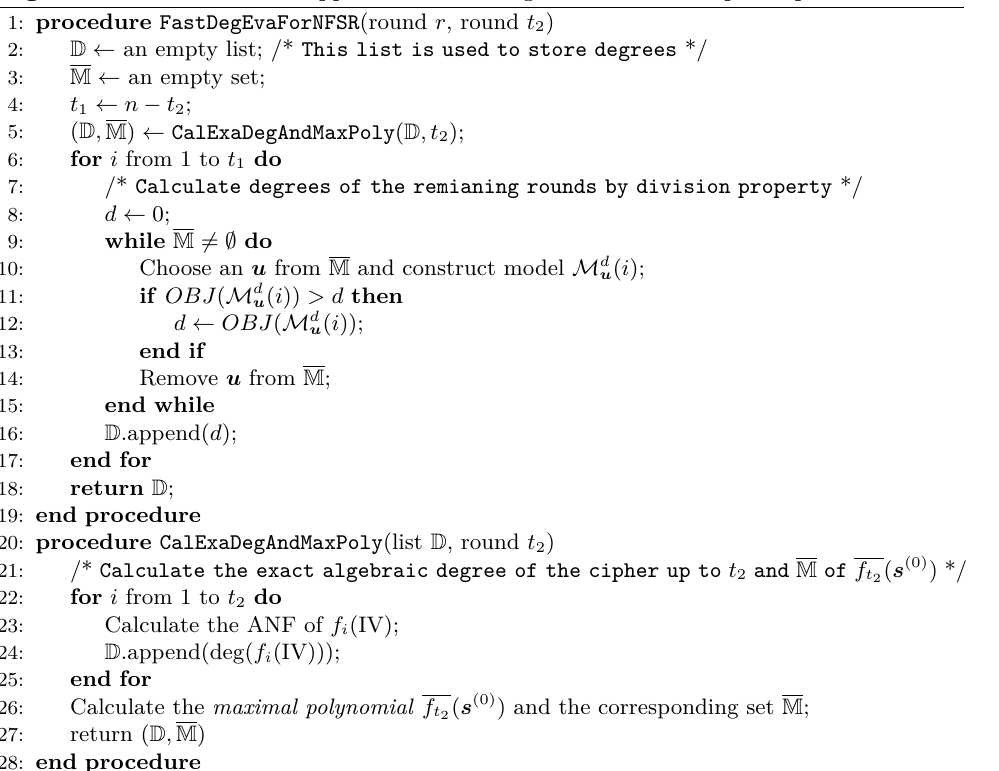
Algorithm 2 Estimate the upper bounds on degree of a stream cipher up to r